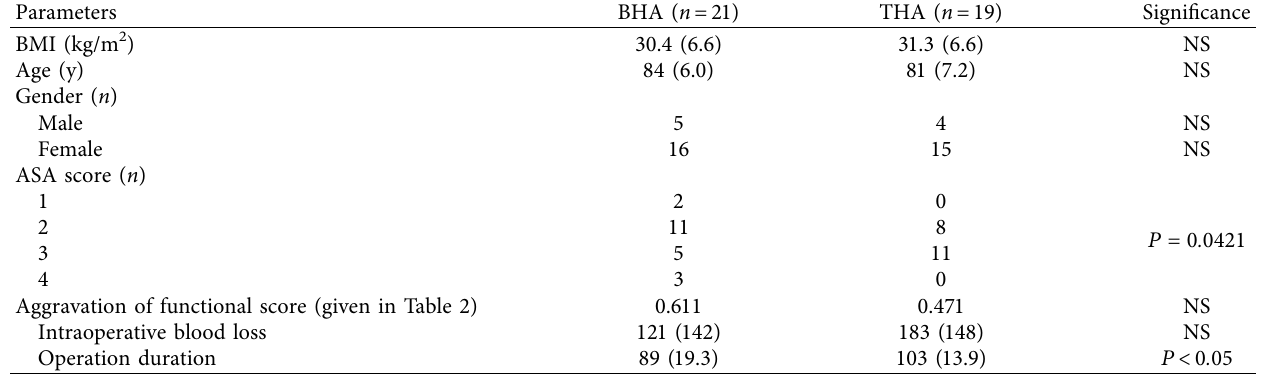
Table 1: Patient